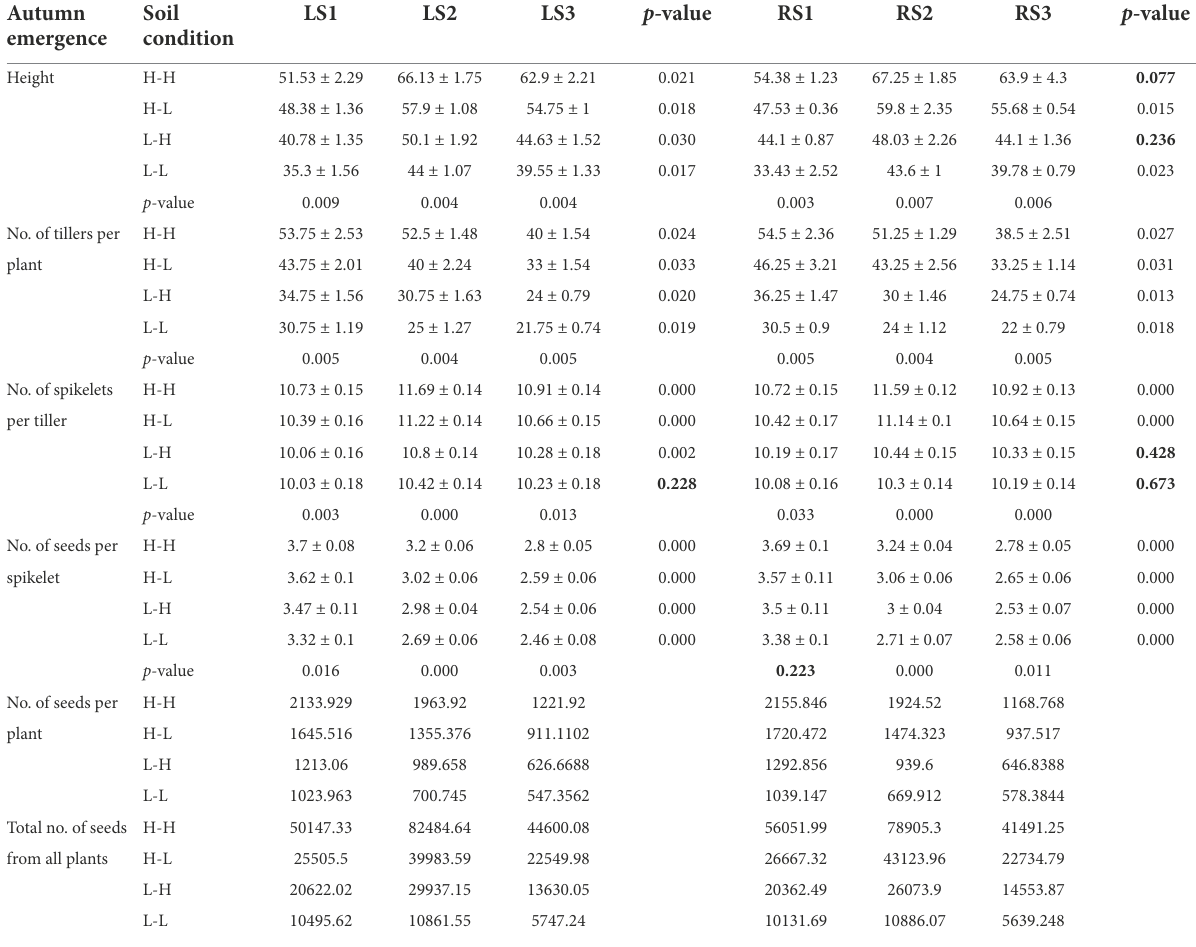
TABLE 1 Plant size and seed production of Aegilops tauschii from autumn germinating seeds. Autumn